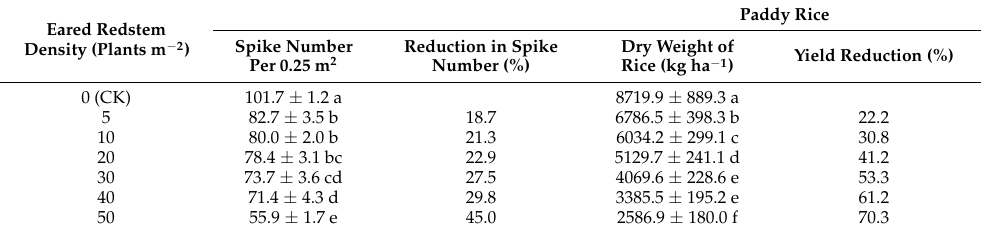
Table 2. Effects of eared redstem on yield (mean ± standard error) of paddy rice in the field at 136 DAS. Different letters within columns indicate significantly different means ( p <